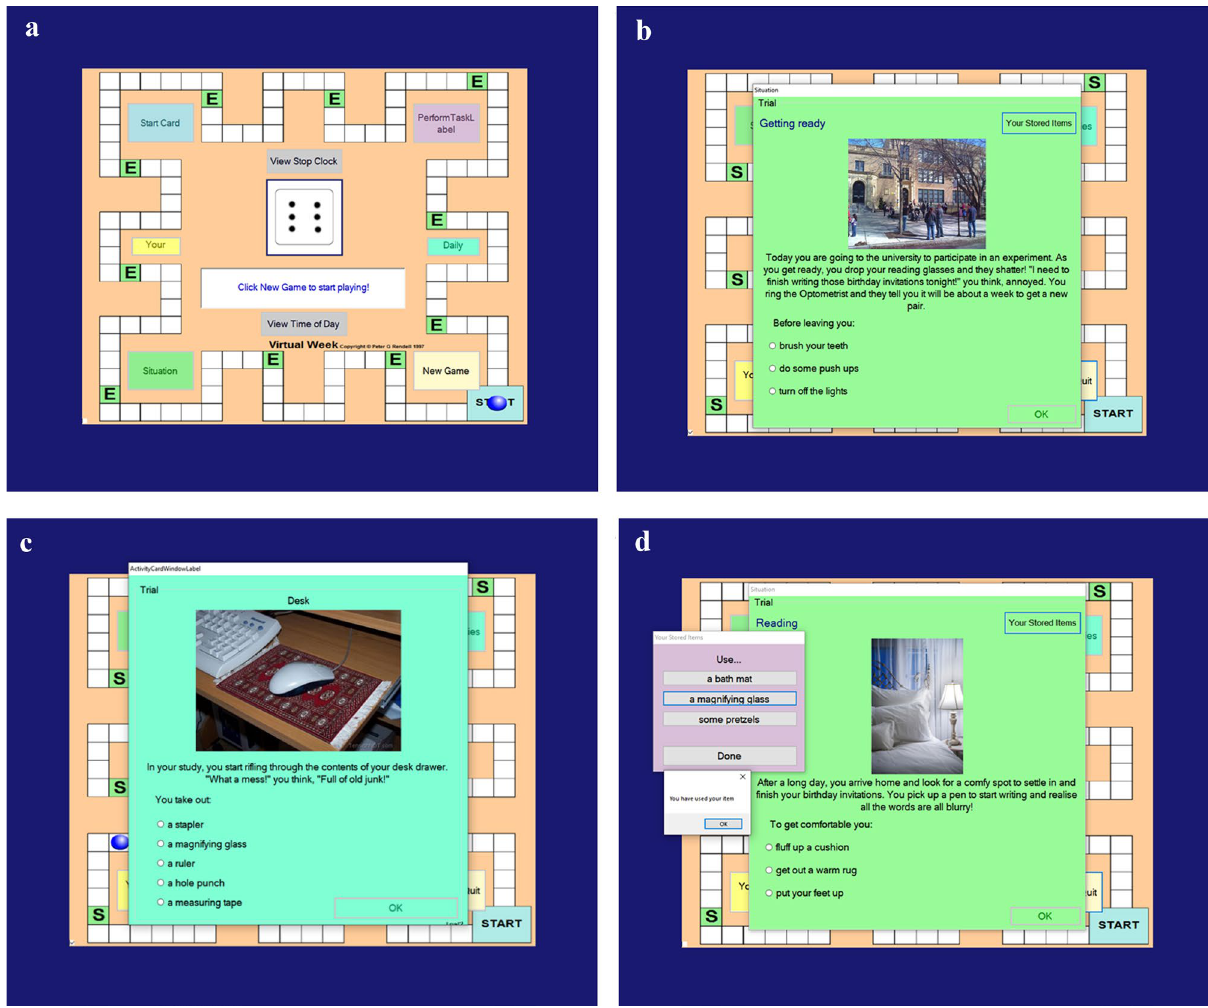
Figure 1. Virtual week-foresight task